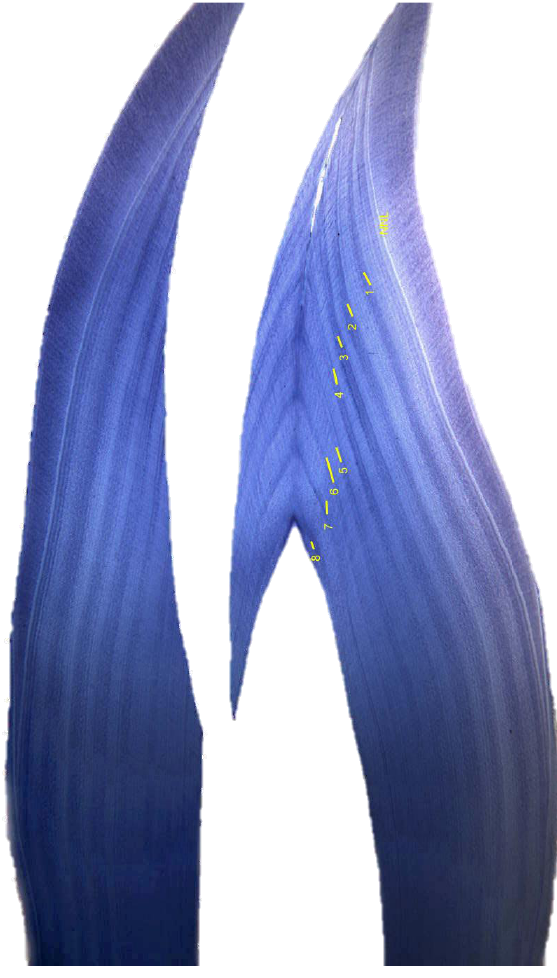
Fig. 2a. Dentinal growth layers identified in stained section of bottlenose dolphin ( Tursiops Truncatus ) age 8 years. NNL is the neonatal